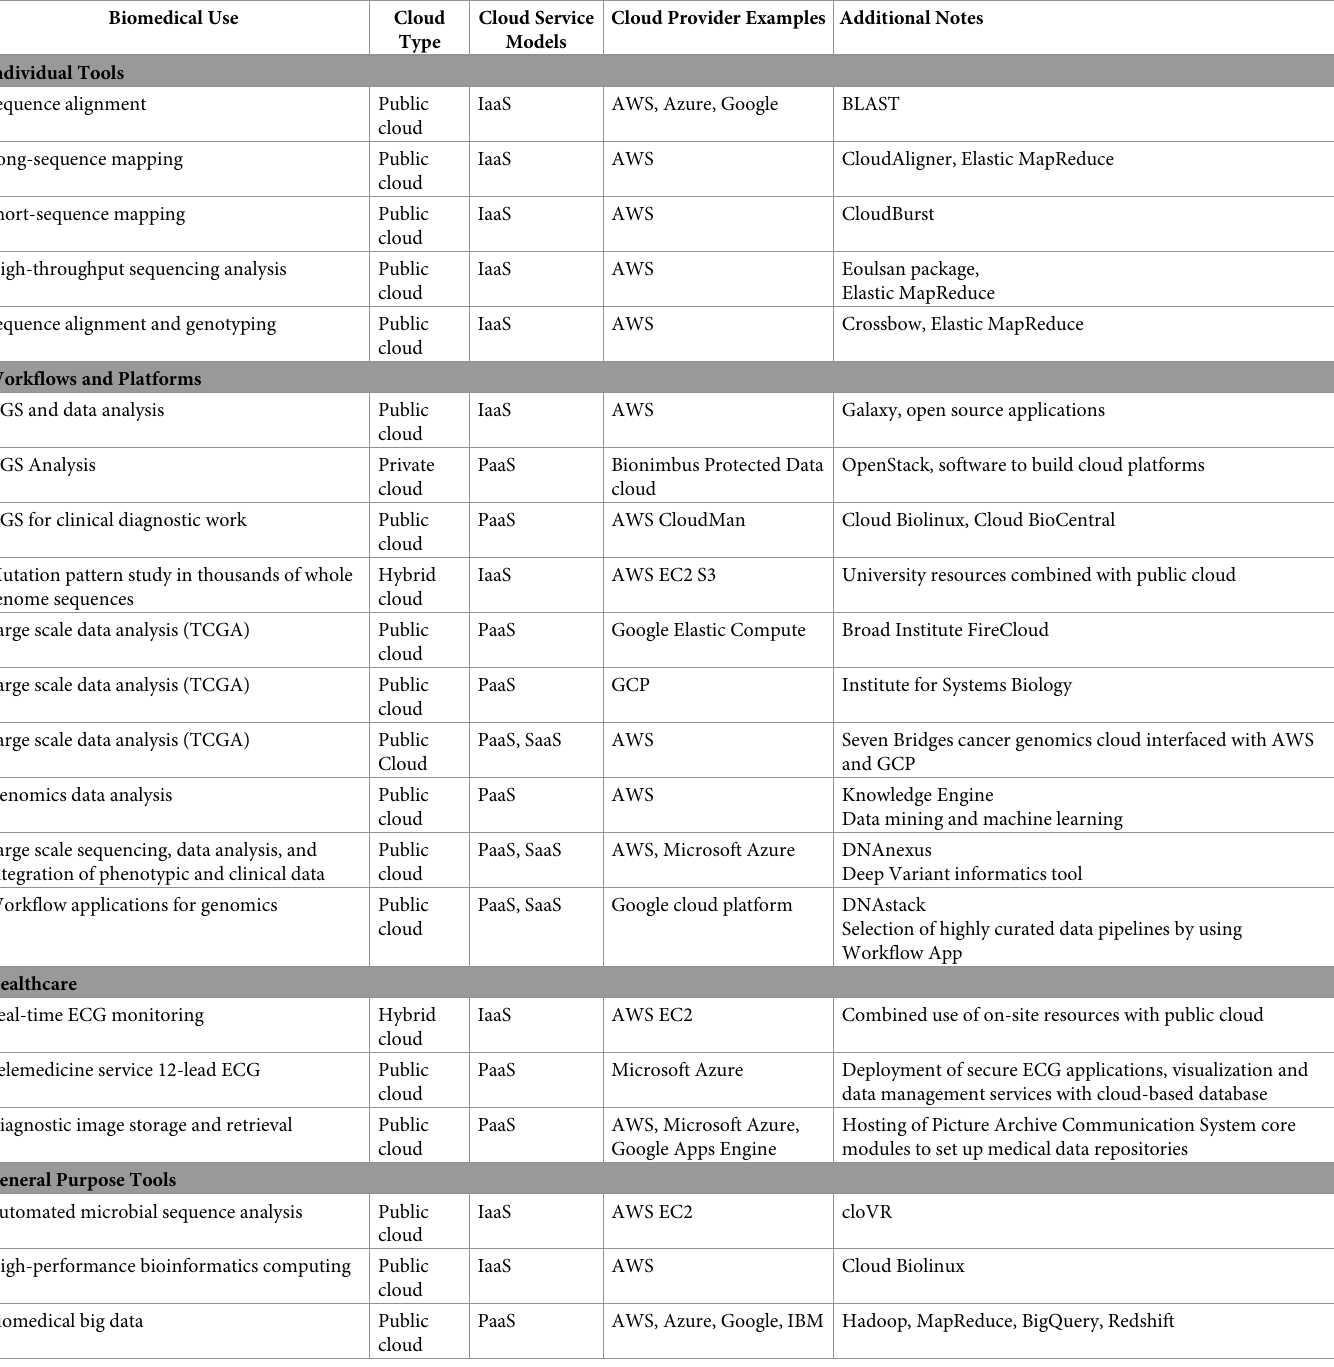
Table 1. Examples of cloud types, service models, workflows, and platforms for biomedical